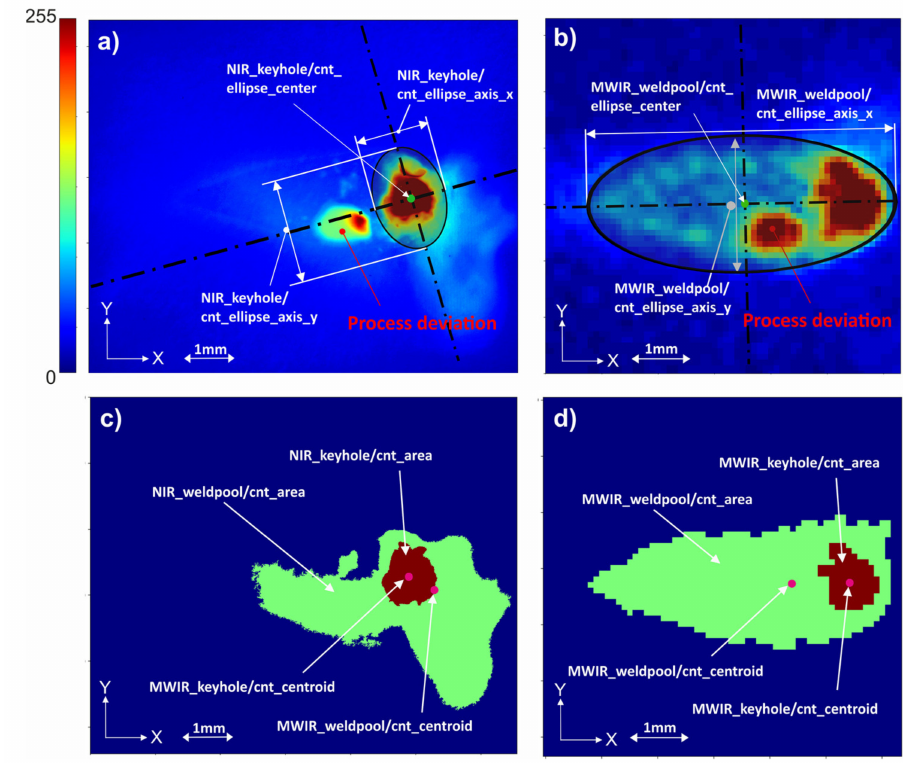
Figure 4. ( a , b ) Original image and geometrical features extracted from keyhole and weld pool regions. ( c , d ) Detected keyhole and weld pool contours (filled) based on two-step binarization of the original